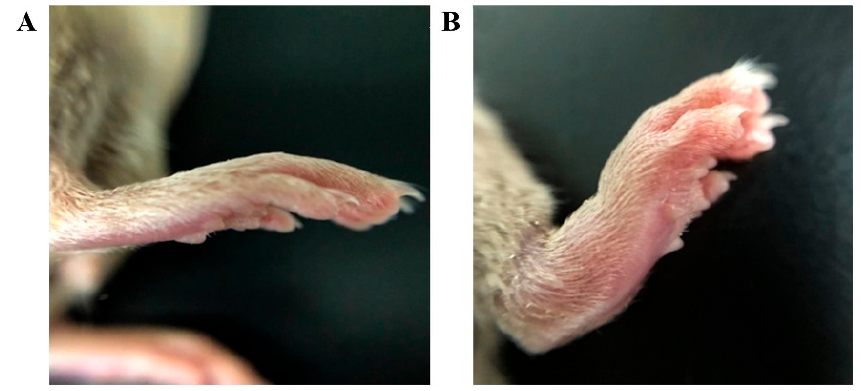
Figure 5. Percutaneous permeation dose-time curves of MTX in MTX-mSiO 2 @PDA measured under different pH conditions. Data are shown as mean ± SD (n = 3).